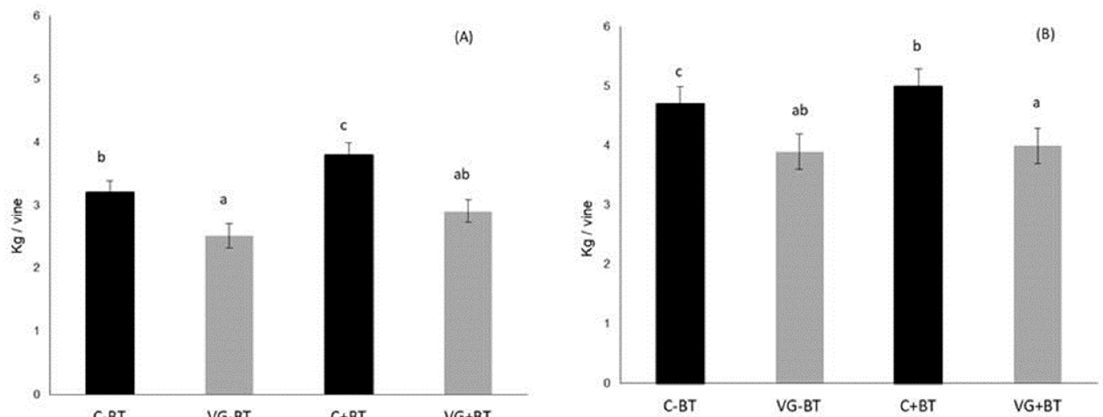
Figure 6. Pruning weight / vine measured in Falanghina vines in 2013 ( A ) and 2014 ( B ). Data are averages of 10 replicates ± SE. Same letter indicates not significant di ff erences at Duncan post hoc test ( p <